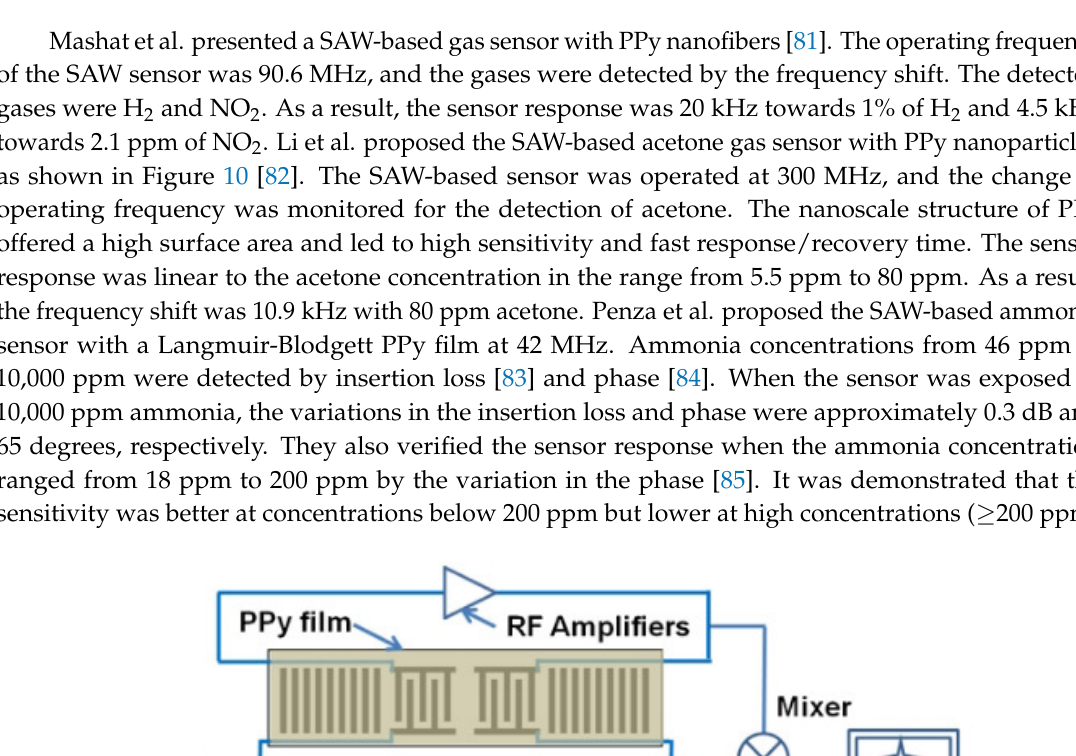
Figure 9. Characterization of the RFID-based ammonia gas sensor with C-PPy. ( a ) Schematic of the RFID sensor tag with C-PPy nanoparticles in the desired position. ( b ) Change in the reflection coefficient of the C-PPy-based RFID sensor tag. (Reprited with permission from [80]. Copyright 2016 American Chemical Society).